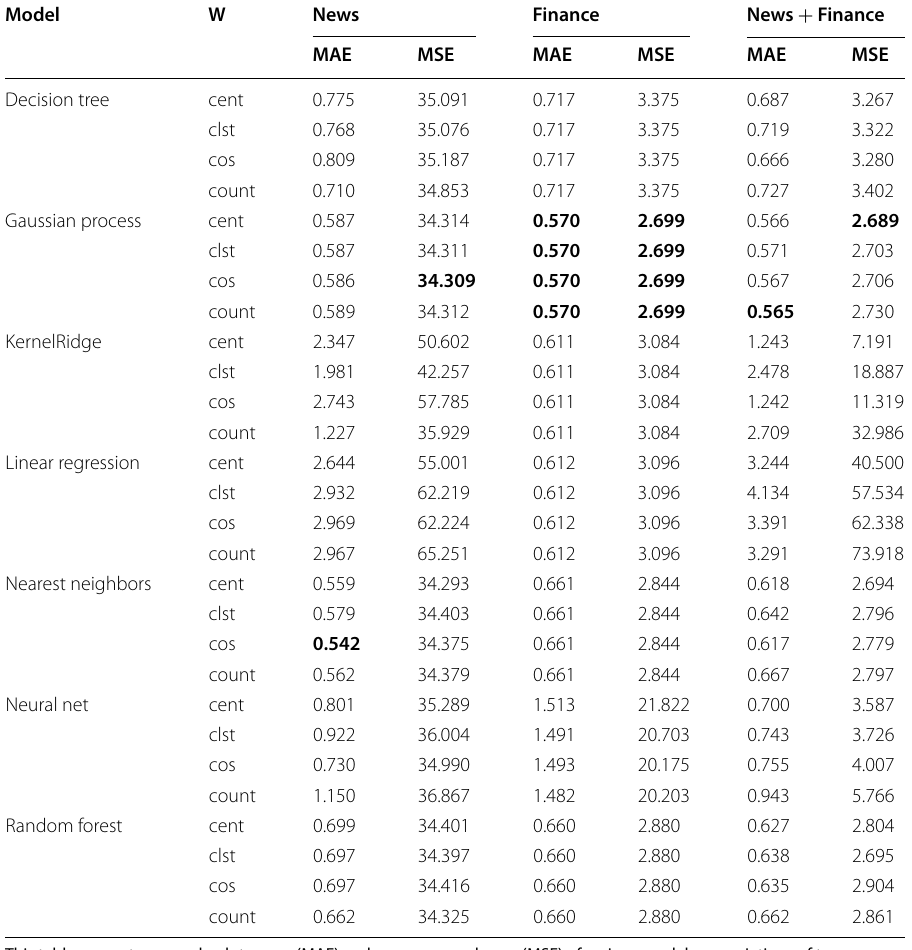
Table 3 Errors of prediction